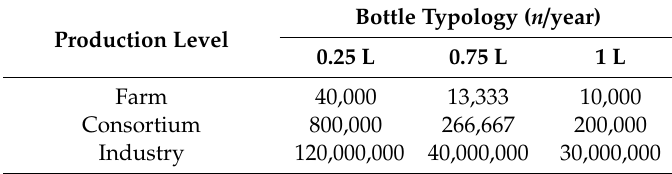
Table 3. Production of bottles (number per year) considered in relation to three production